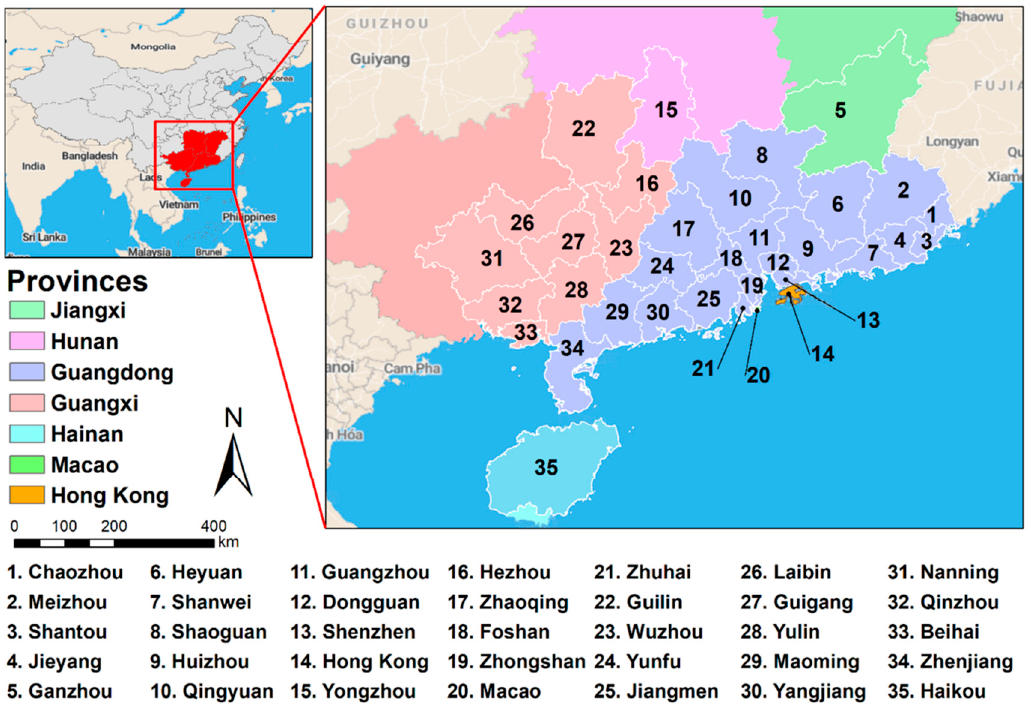
Figure 2. Study areas affected by the Typhoon Mangkhut in China.